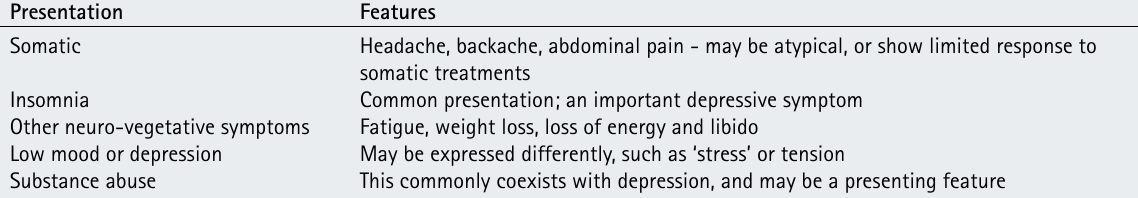
TaBle i. clinical PreSenTaTionS oF coMMon MenTal DiSorDerS in PriMarY Hiv/aiDS care